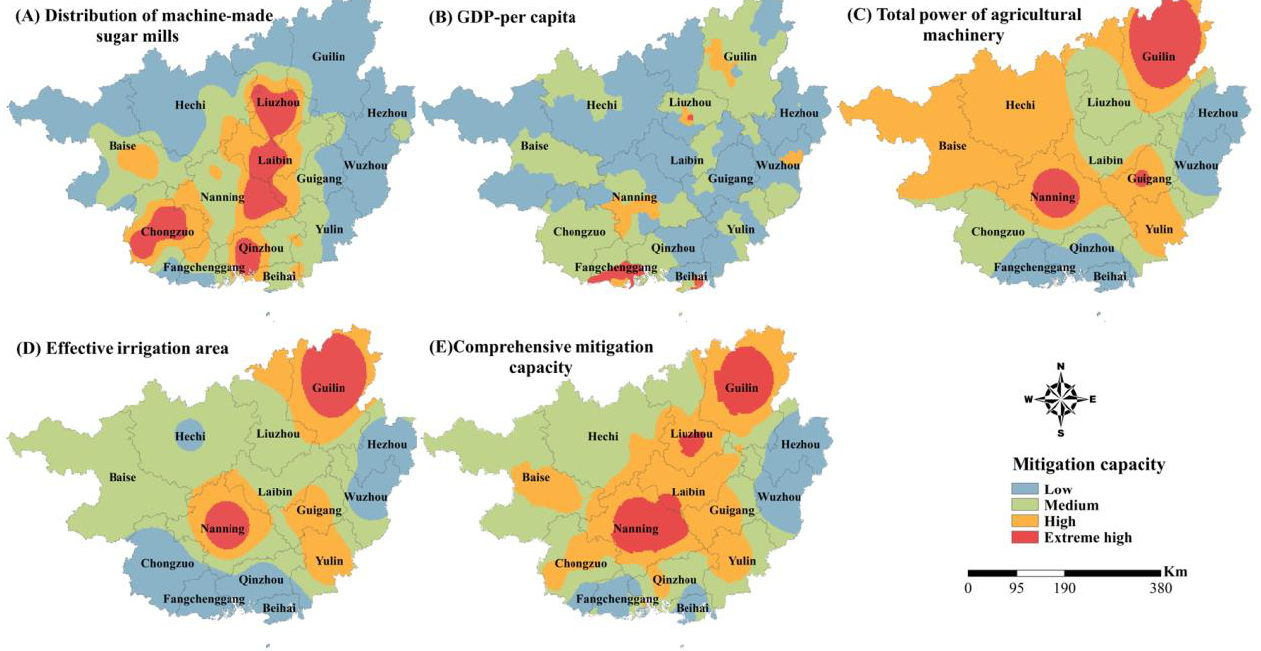
Figure 11. Spatial changes in the mitigation capability for drought disaster of sugarcane in Guangxi. ( A – E ) represent the Distribution of machine-made sugar mills, GDP-per capita, Total power of agricultural machinery, Effective irrigation area, and Comprehensive mitigation capacity,